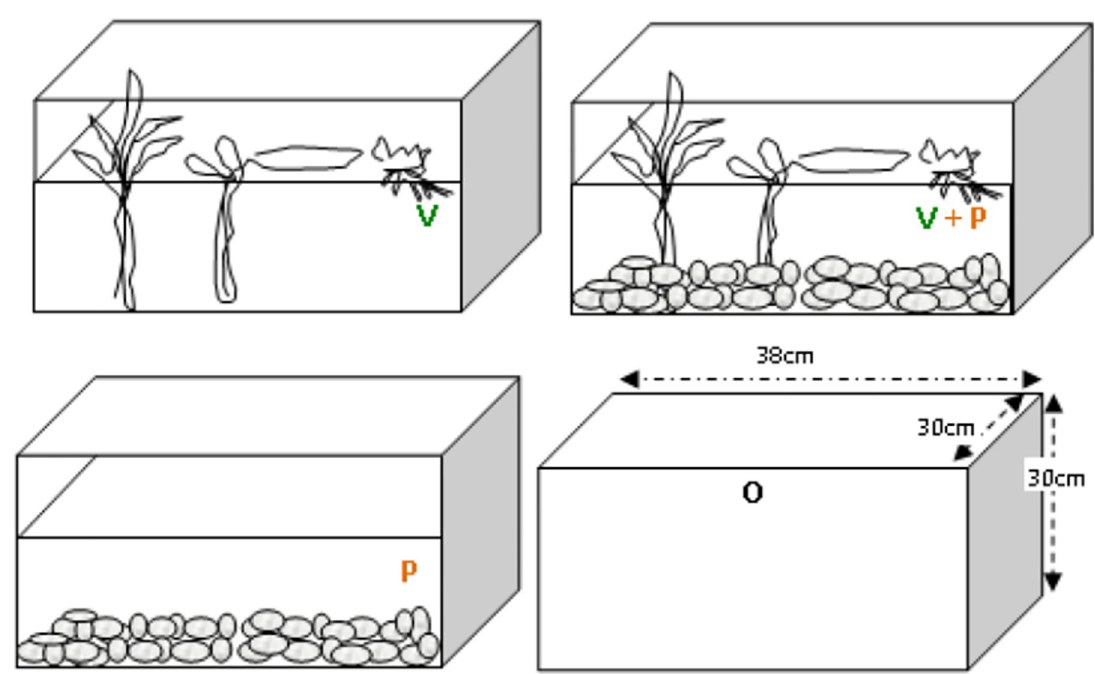
Fig 2. Illustration of the habitat conditions used to evaluate the influence of the habitat complexity on the IGP system. Four different habitat conditions in the glass aquaria using vegetations (V), vegetations and pebbles (V+P), pebbles (P) and open conditions (O) were created in the glass aquarium. The condition (O) is used as simple condition reflects no habitat complexity in contrast to the rest three. Glass aquarium: Experimental mesocosm Water– 35L tap: pond; (pH– 7.6 to 8.2; temperature observed 29–32˚C) Observation on predation was measured for 24 h. for each